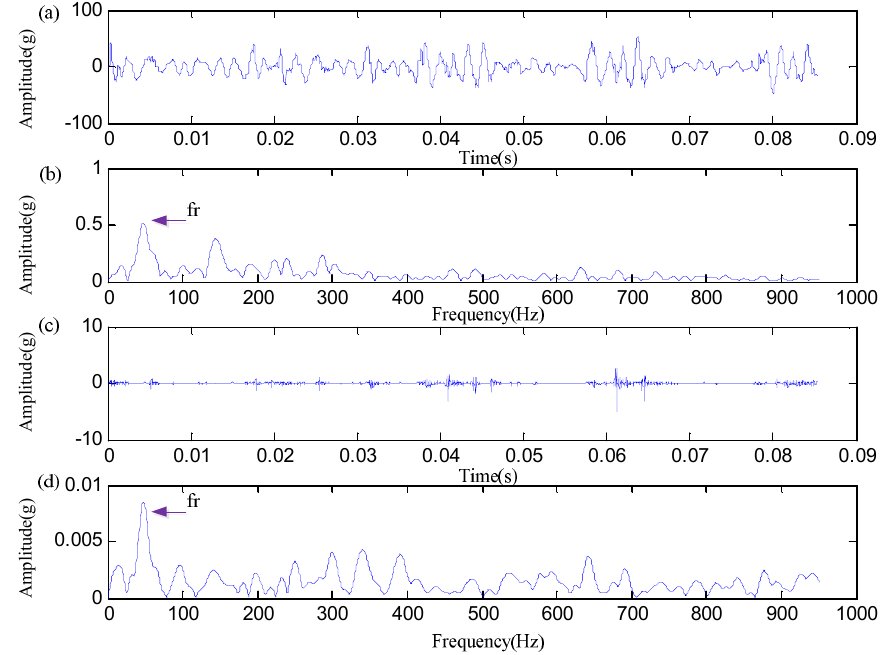
Figure 13. ( a ) Test signal ( b ) Envelope spectrum ( c ) Filtering results of MED ( d ) Envelope spectrum.